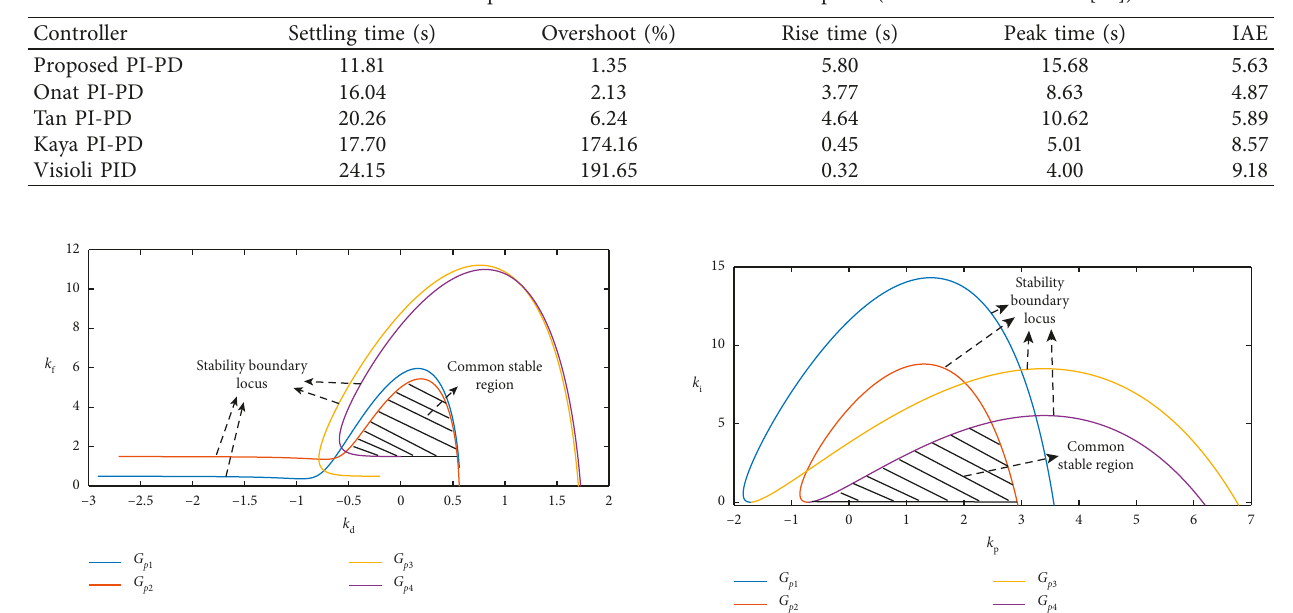
Figure 10: Stability boundary loci of outer-loop PI controller for uncertain systems in example C.